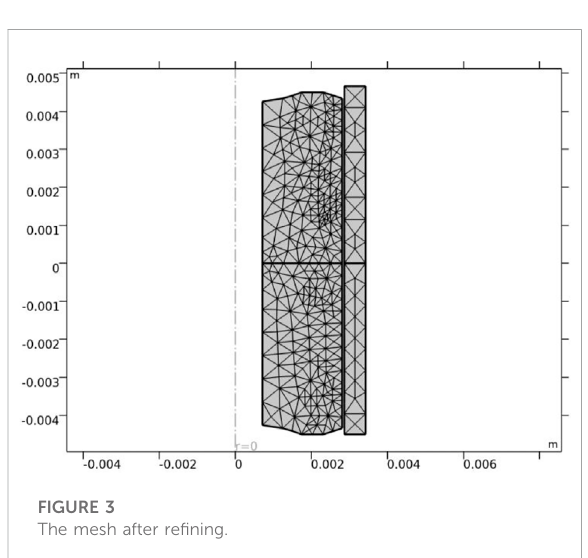
FIGURE 3 The mesh after re fi